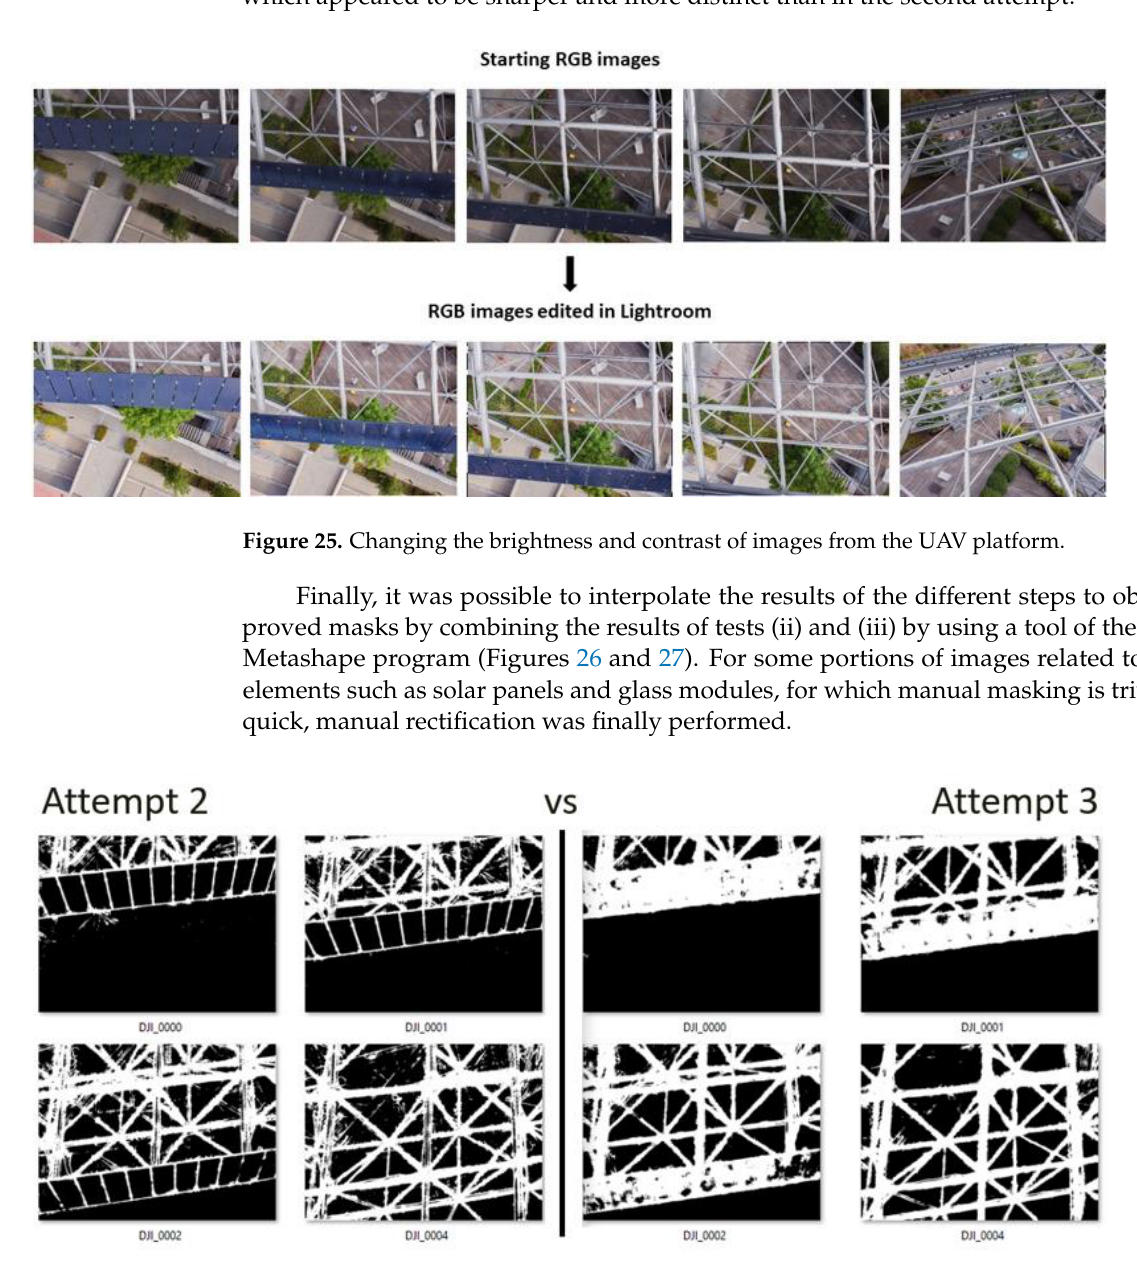
Figure 26. Masks resulting from the third attempt compared to those from the second attempt. Images related to flight 3.